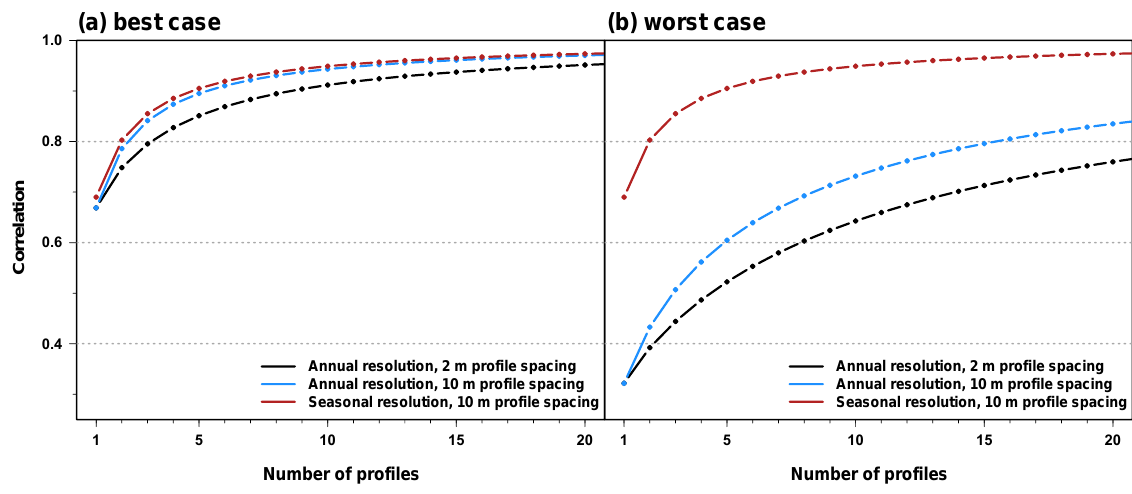
Figure 8. Representativity of a δ 18 O firn profile stack expressed as the correlation with a hypothetical climate signal depending on the number of profiles averaged and their inter-profile spacing. For annual resolution, the two limiting cases discussed in the text are displayed ( a best-case scenario, b worst-case scenario), each for 2m (black) as well as 10m (blue) inter-profile spacing. As a reference, in each case the seasonal representativity is shown in red for 10m inter-profile spacing.